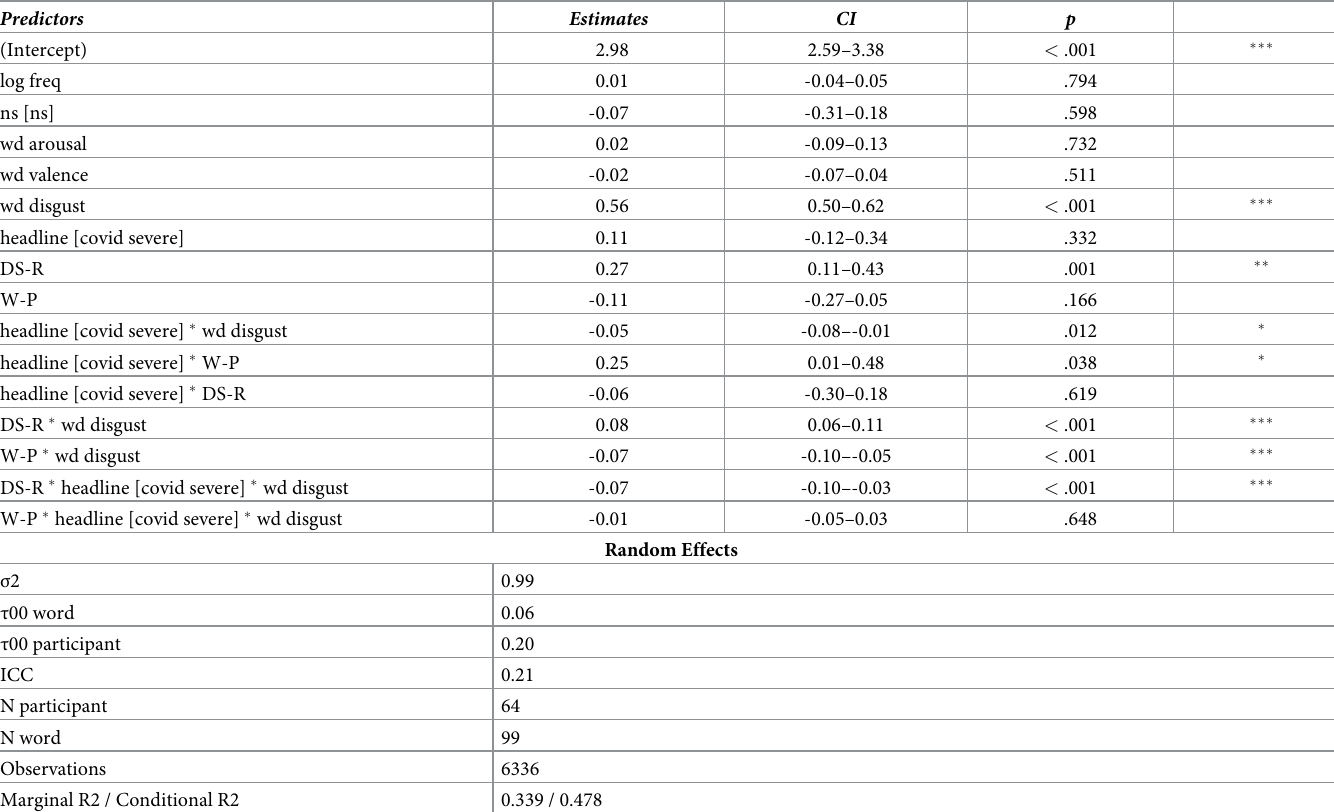
Table 3. Summary of the linear mixed-effects model with disgust rating as a dependent variable.